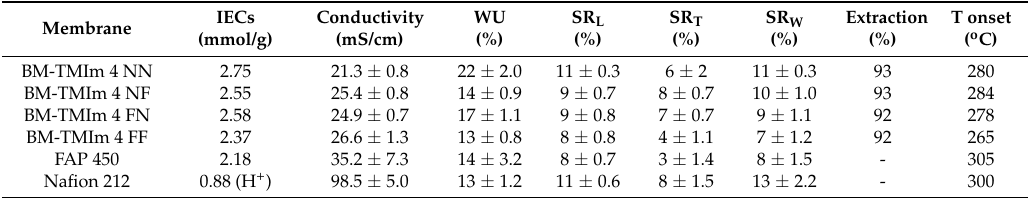
Table 2. Membrane characterization data.